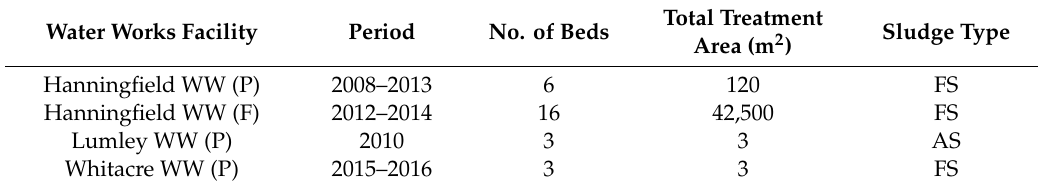
Table 3. STRBs in England for water works sludge treatment (P = pilot, F = full-scale, FS = ferric sludge, AS = alum sludge, WW = Water Works)